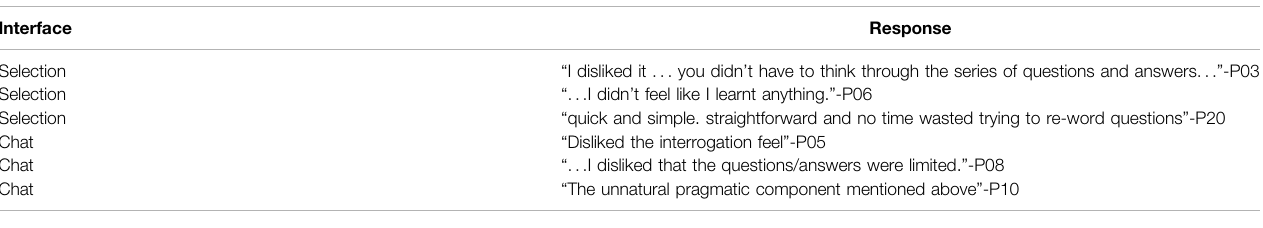
TABLE 5 | Sample student response to “ What did you like or dislike about the [interface]? ” Interface